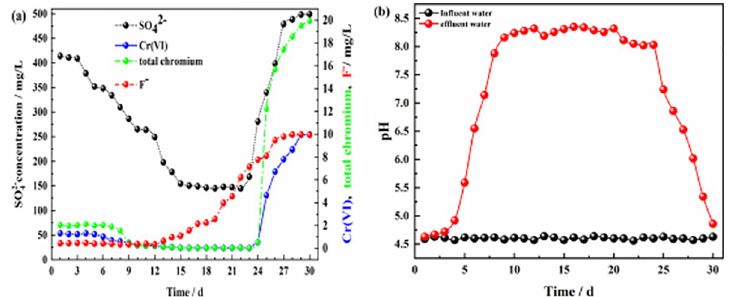
Fig 11. Effluent of dynamic column #6. (a) Effluent concentration of each pollutant ion; (b) pH values of influent and effluent